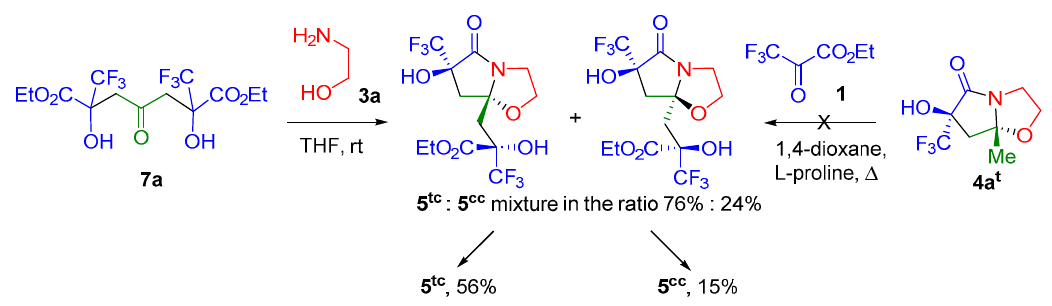
8 of 24 Table 2. The ratio of diastereomeric products 4 and 8 obtained by two- and three-component meth- ods. Products ( δ F , ppm), 19 F NMR data